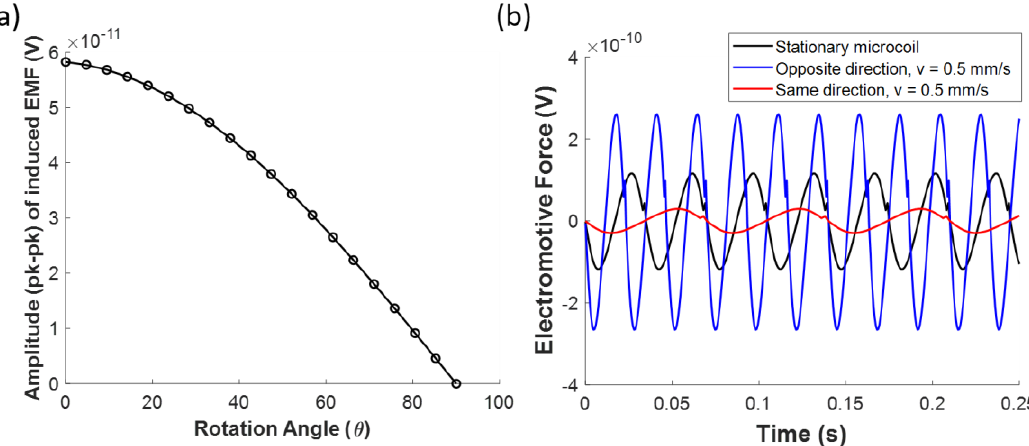
Figure 3. Measurement of the direction of blood flow by moving the microcoil along the capillary. ( a ) A graph depicting the peak-to-peak amplitude of the induced electromotive force (EMF) with respect to the rotation angle ( θ ) of the microcoil in the z -axis. ( b ) The trajectories of the EMF when the microcoil moves in the opposite direction to (blue line) and same direction as (red line) the blood flow, at a velocity of 0.5 mm / s, whereas the EMF with the black curve is that generated at the stationary